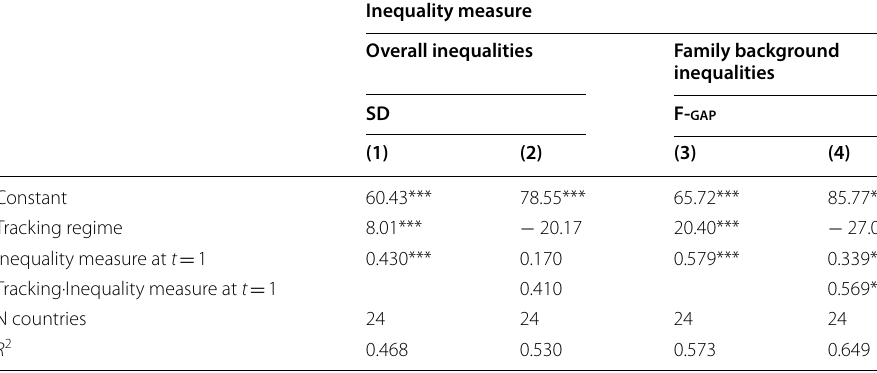
Under the heading SD we report results relative to the effects of tracking on the country standard deviation Under the heading F‑gap we report results relative to the effects of tracking on the difference between tertiary educated parents with the largest number of books and no tertiary educated parents with the lowest number of books: Columns (1) and (3) refer to the model with no interaction; columns (2) and (4) to models with interaction between the tracking indicator and inequality at